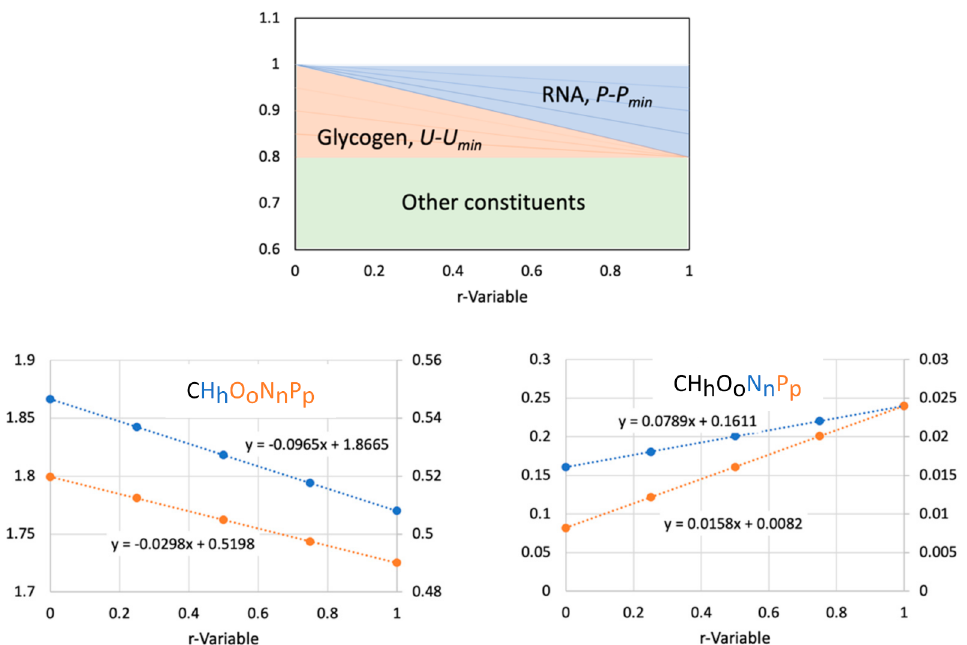
Figure A6. Adjustment of the cell biomass formula. ( Top ) RNA and glycogen, two major changeable cell components. ( Bottom) Empirical biomass formula with H and O subscripts linearly decreasing with r ( left ) and the N and P contents increasing with r ( right